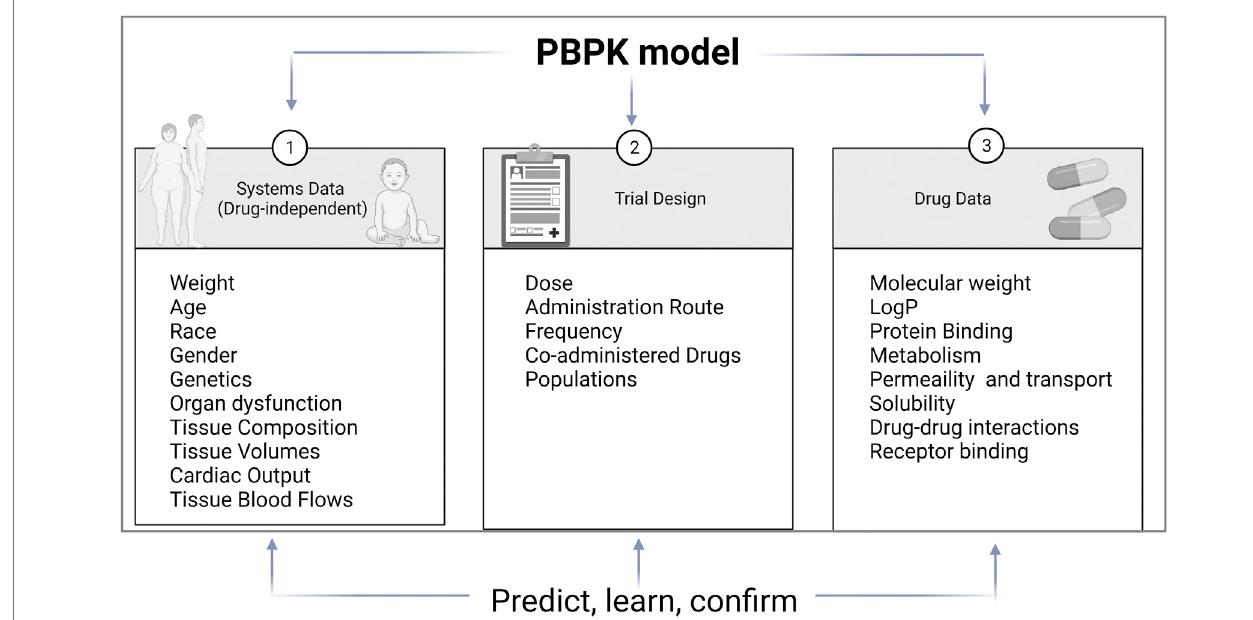
FIGURE 2 | PBPK model components. PBPK models are separated into three main components: the drug, the system and the trial. Drug data include physicochemical and experimental or predicted ADME data. System data include physiological data which relevant for the ADME properties of drugs. Trial data include information on trial design such as administration route, dose regimen or trial duration (adapted from (Jamei 2016))